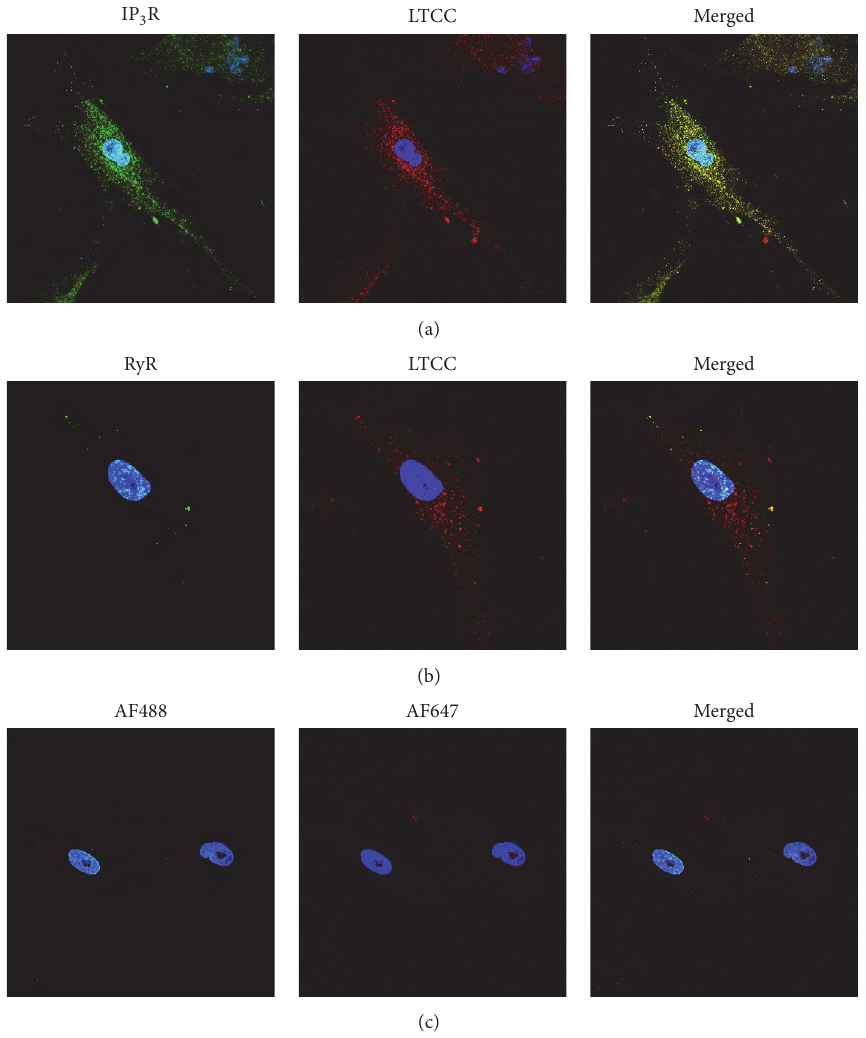
Figure 5: Immunostaining of CPCs shows expression and localization of the LTCC and IP 3 R. CPCs were fixed, permeabilized, and incubated with primary antibodies against the L-type Ca 2+ channel (LTCC, Cav2.1 subunit), type 2 inositol 1,4,5-trisphosphate receptor (IP 3 R), or type 2 ryanodine receptor (RyR). Cells were then incubated with either Alexa Fluor 488 (IP 3 R and RyR; green) or Alexa Fluor 647 (LTCC; red). Nuclei are stained with DAPI (blue). Expression of the IP 3 R and LTCC is shown in (a), while expression of the LTCC and the RyR is shown in (b).Cellswere alsoincubated withonly secondary antibodies to determinenonspecificbinding in(c). Images arerepresentative of3